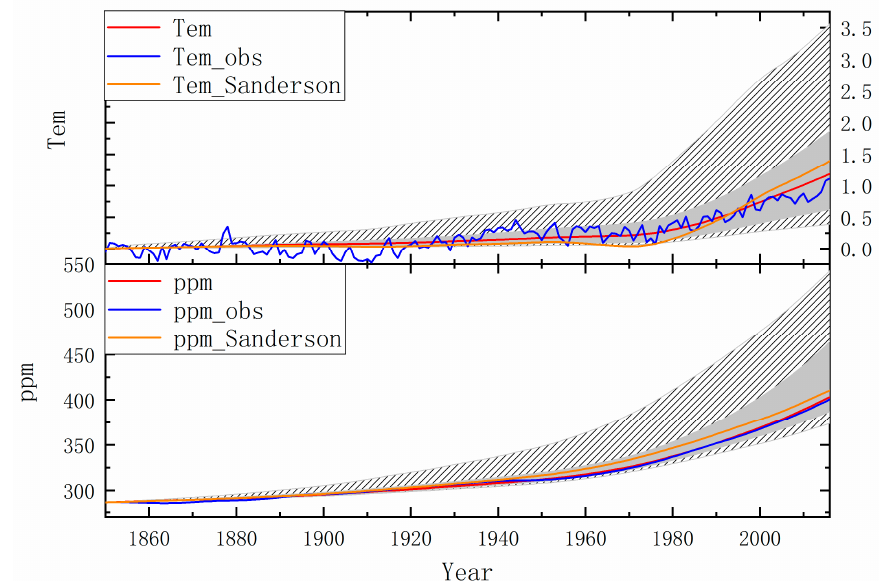
Figure 5. Model output temperature and CO 2 concentration with grey shaded areas showing the uncertainty range and dashed areas show the uncertainty range of Sanderson’s.